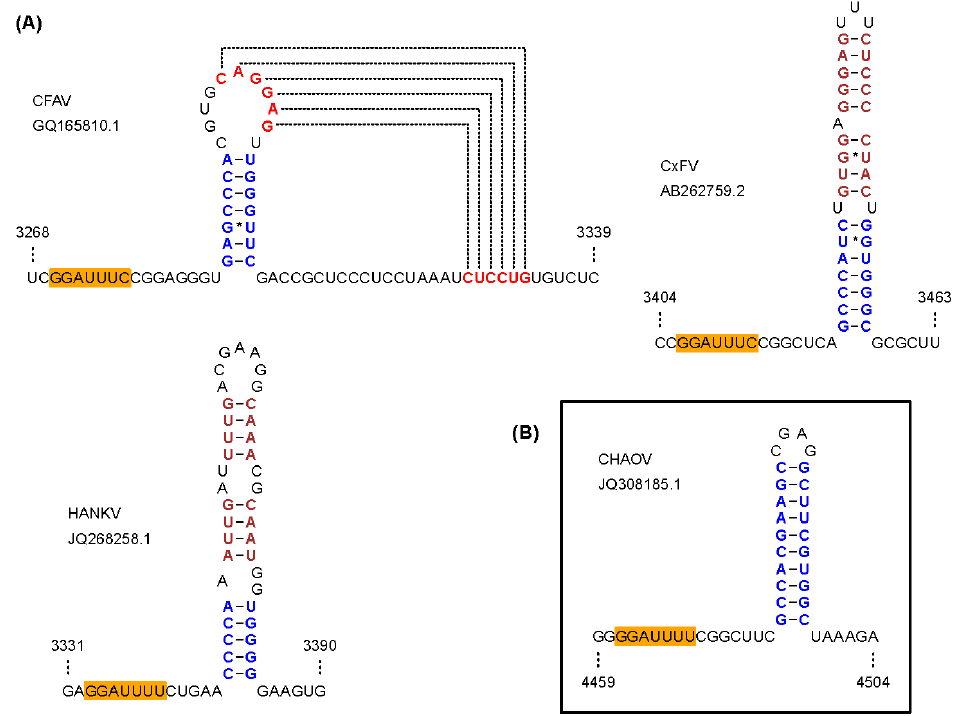
Figure 4. Predicted frameshift-stimulatory RNA structures in ISFs. ( A ) Frameshifting in cISFs is predicted to be stimulated by an RNA pseudoknot structure in the CFAV clade, and an RNA stem-loop structure in the CxFV and HANKV clades; ( B ) Frameshifting in the CHAOV clade of dISFs is predicted to be stimulated by an RNA stem-loop